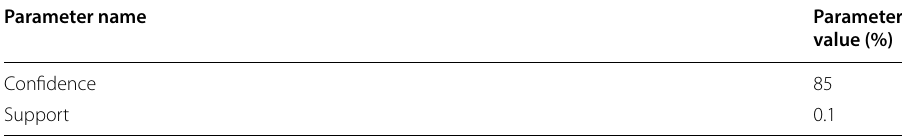
Table 20 Association rule